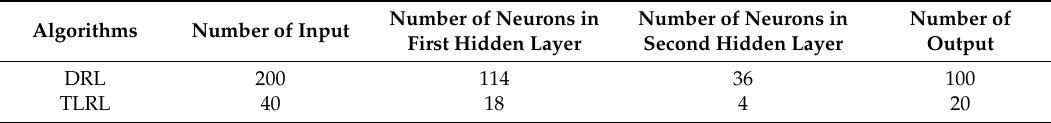
Table 2. The setting of CNN in following